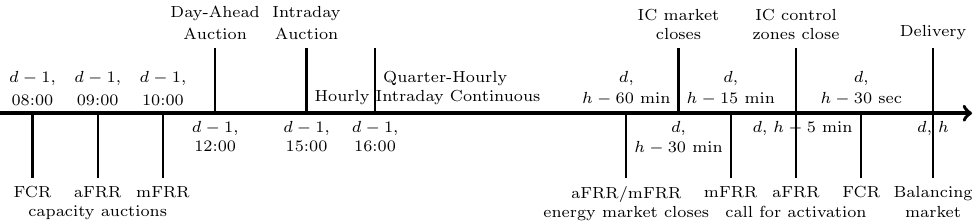
Figure 1. The daily routine of the German electricity spot ( top ) and balancing ( bottom ) markets. d , h correspond to the day and hour of the delivery,